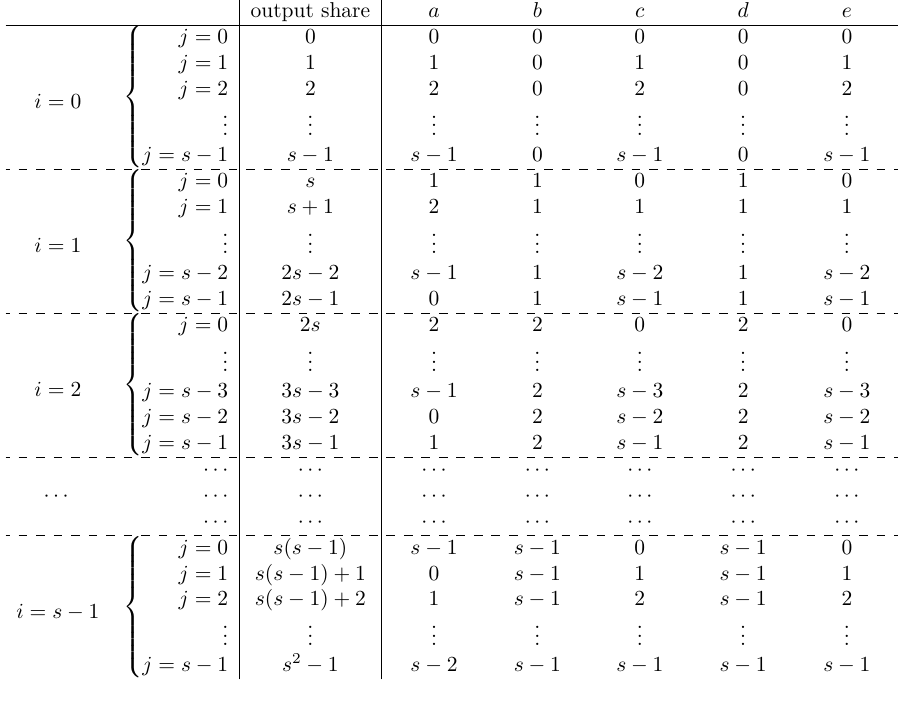
Table 2: Index configuration of our d th -order solution